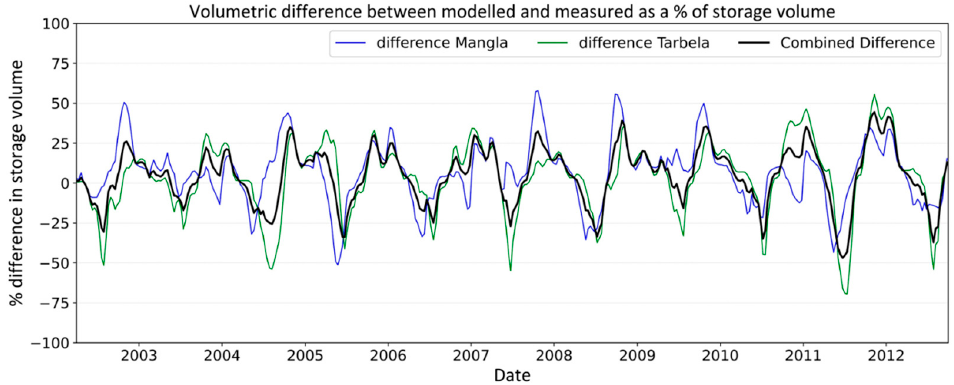
Figure 10. Volumetric difference between modelled and measured as a percentage of storage vol-